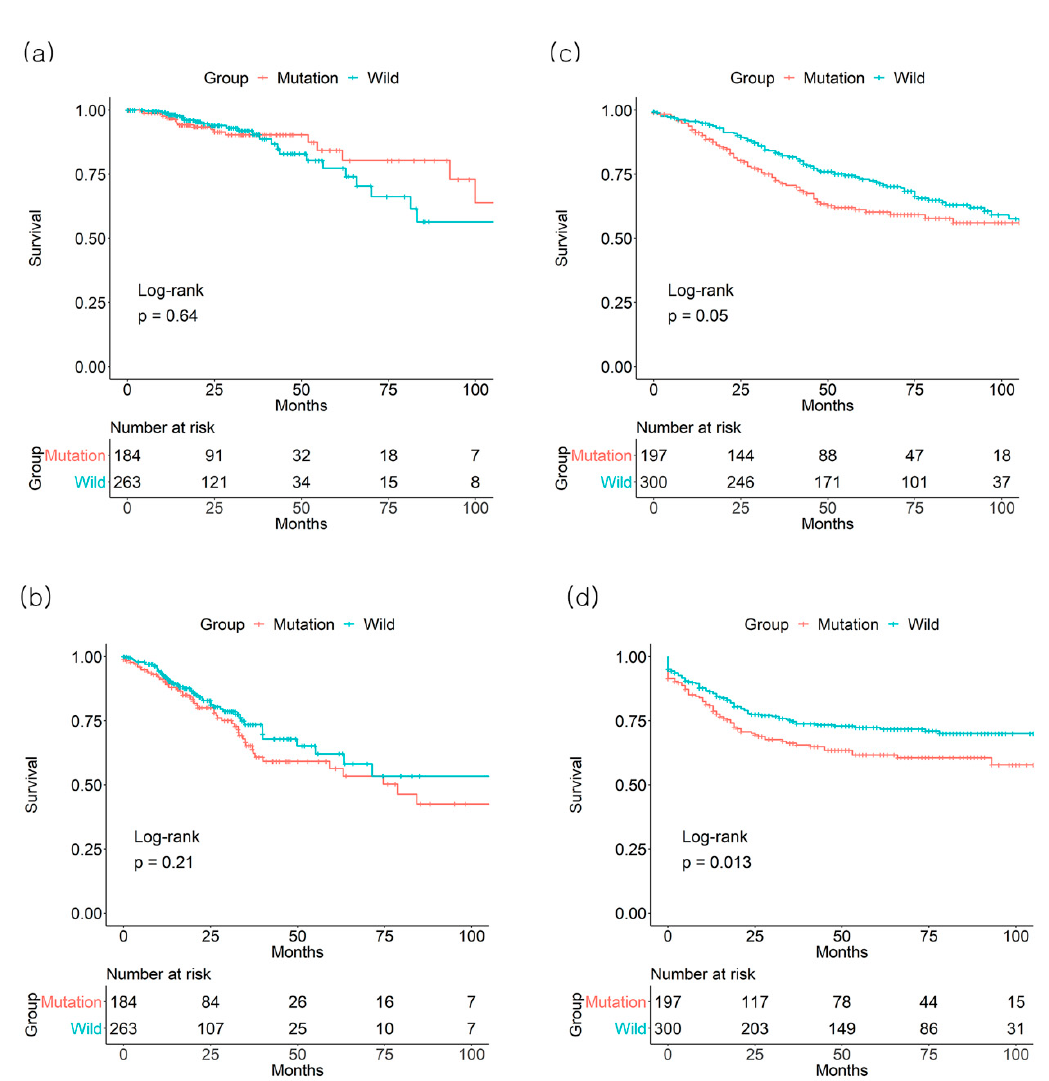
Figure 4. Effect of KRAS mutation on ( a ) 3-year overall survival and ( b ) 3-year disease-free survival from the The Cancer Genome Atlas (TCGA) database and on ( c ) 3-year overall survival and ( d ) 3-year disease-free survival from the GSE39582 database of colorectal cancer patients of all stages. In the GSE39582 dataset, KRAS mutation positivity had a detrimental effect on 3-year OS rate (71.9% mutation (+) vs. 83% mutation ( − ), p = 0.05, number of patients: 116 vs. 214) and DFS rate (66.3% mutation (+) vs. 74.6% mutation ( − ), p = 0.013, number of patients: 98 vs. 181) (Figure 4). Among the CRC stages, stage III patients with KRAS mutation exhibited a lower 3-year OS (71.9% mutation (+) vs. 89.4% mutation ( − ), p = 0.02, number of patients: 41 vs. 71) and DFS (54.0% mutation (+) vs. 73.5% mutation ( − ), p = 0.022, number of patients: 31 vs. 59) rates (Figure 5).